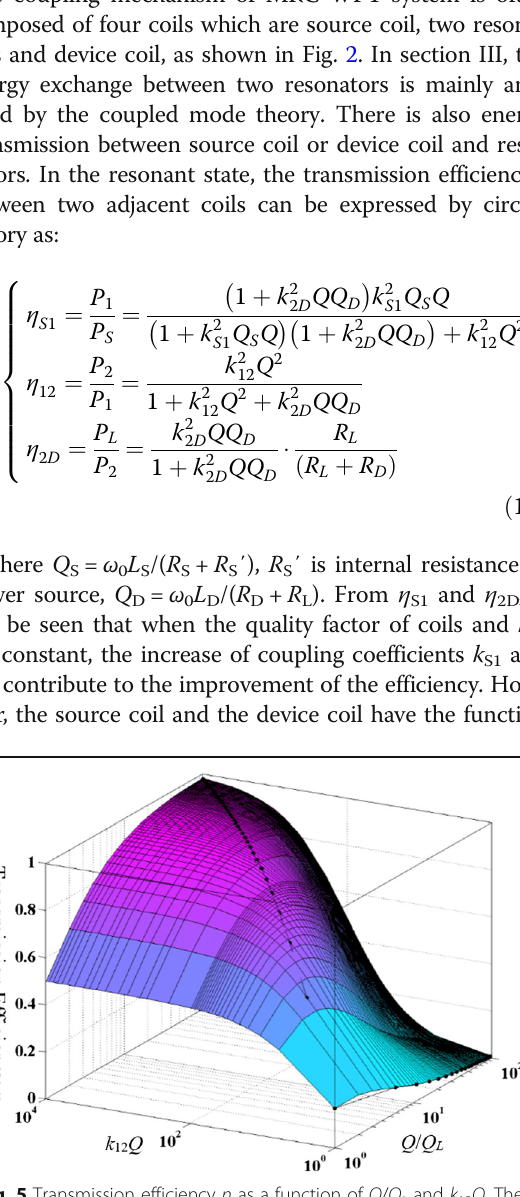
Fig. 5 Transmission efficiency η as a function of Q / Q L and k 12 Q . The abscissa axis is Q / Q L and k 12 Q . For system efficiency, it is related to many factors. In this paper, we combine the relevant factors to see the relationship of efficiency more directly